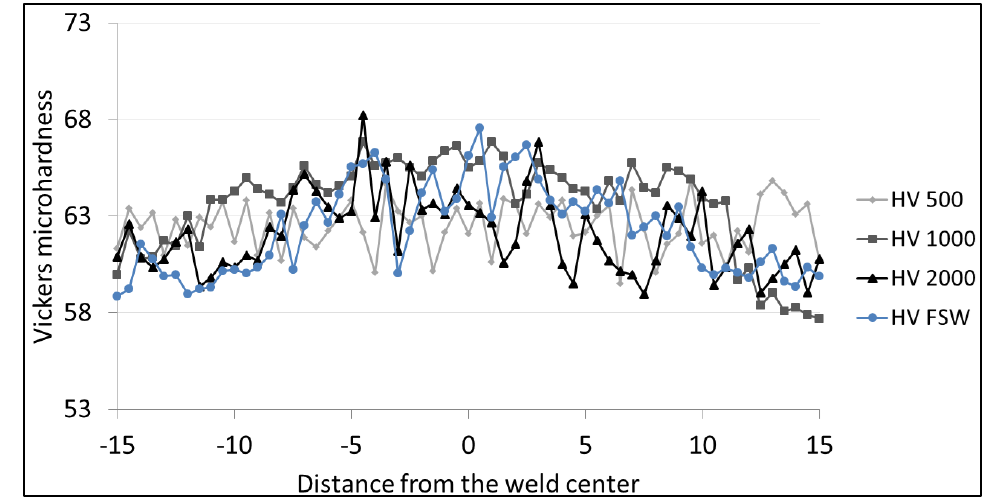
Figure 18. Microhardness profile across FSW and LFSW welds at 1.5 mm from the bottom surface.